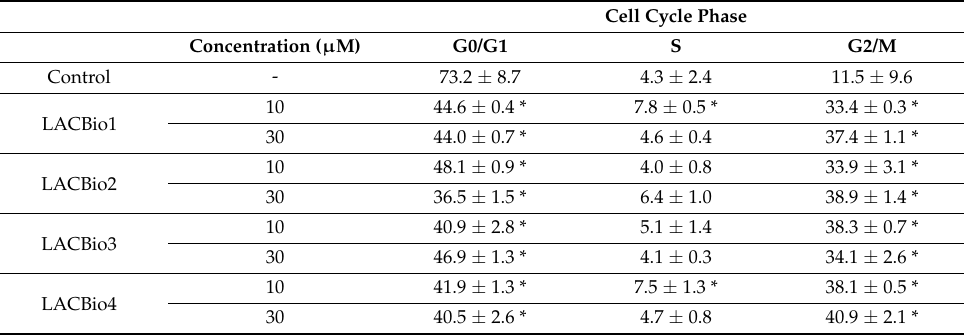
Table 1. Effects of LACBio1, LACBio2, LACBio3 and LACBio4 on MDA-MB 231 cell cycle phases. Samples of cells were stained with propidium iodide, and the cellular DNA content was determined by flow